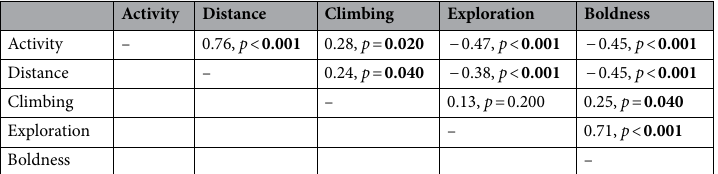
Table 4. Spearman’s rank correlations, based on first behavioural test (after capture, before release) of signal crayfish at all sites. Significant values are in